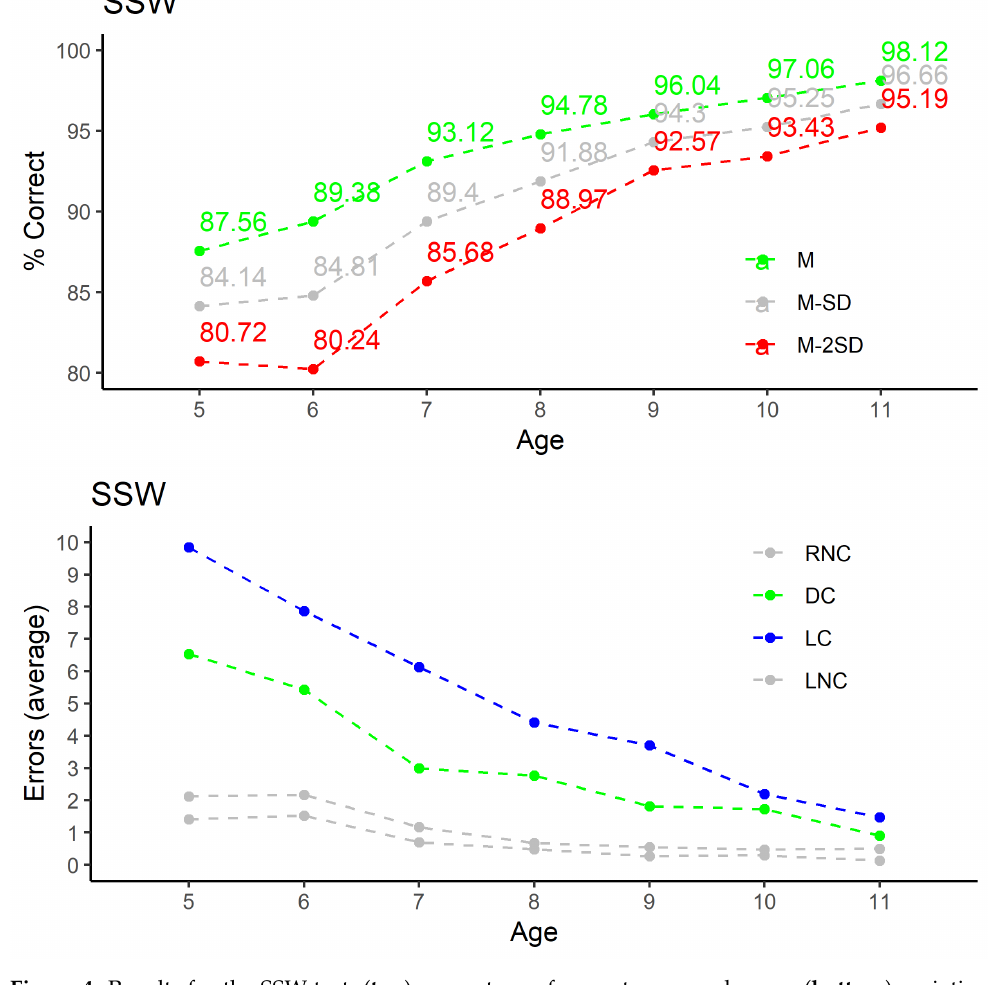
Figure 4. Results for the SSW test: ( top ) percentage of correct answers by age; ( bottom ) variation with age of average values for RNC, RC, LC, and